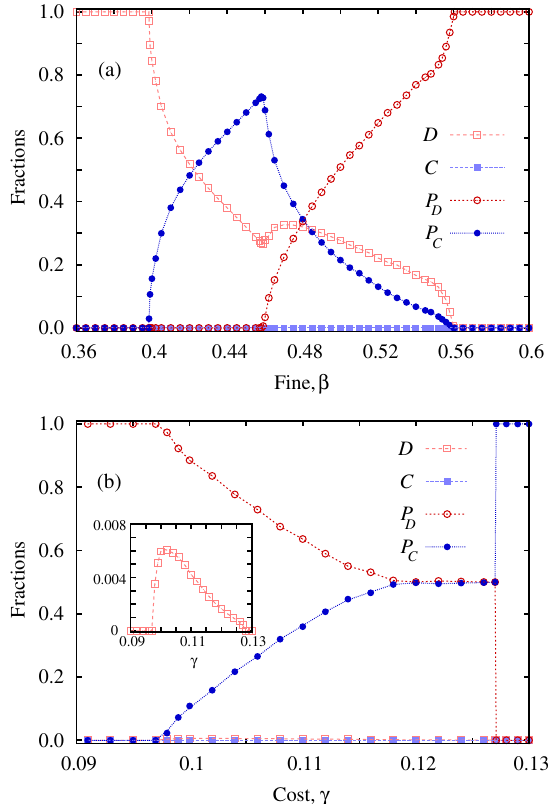
FIG. 7. Two representative cross sections of the phase diagram depicted in Fig. 7, as obtained for the punishment cost γ ¼ 0 . 04 (a) and the punishment fine β ¼ 0 . 9 (b). Depicted are stationary fractions of the four competing strategies dependent on the other punishment parameter from the one used for the cross section. The inset in (b) shows just how tiny the fraction of nonpunishing defectors in the stationary state can be.